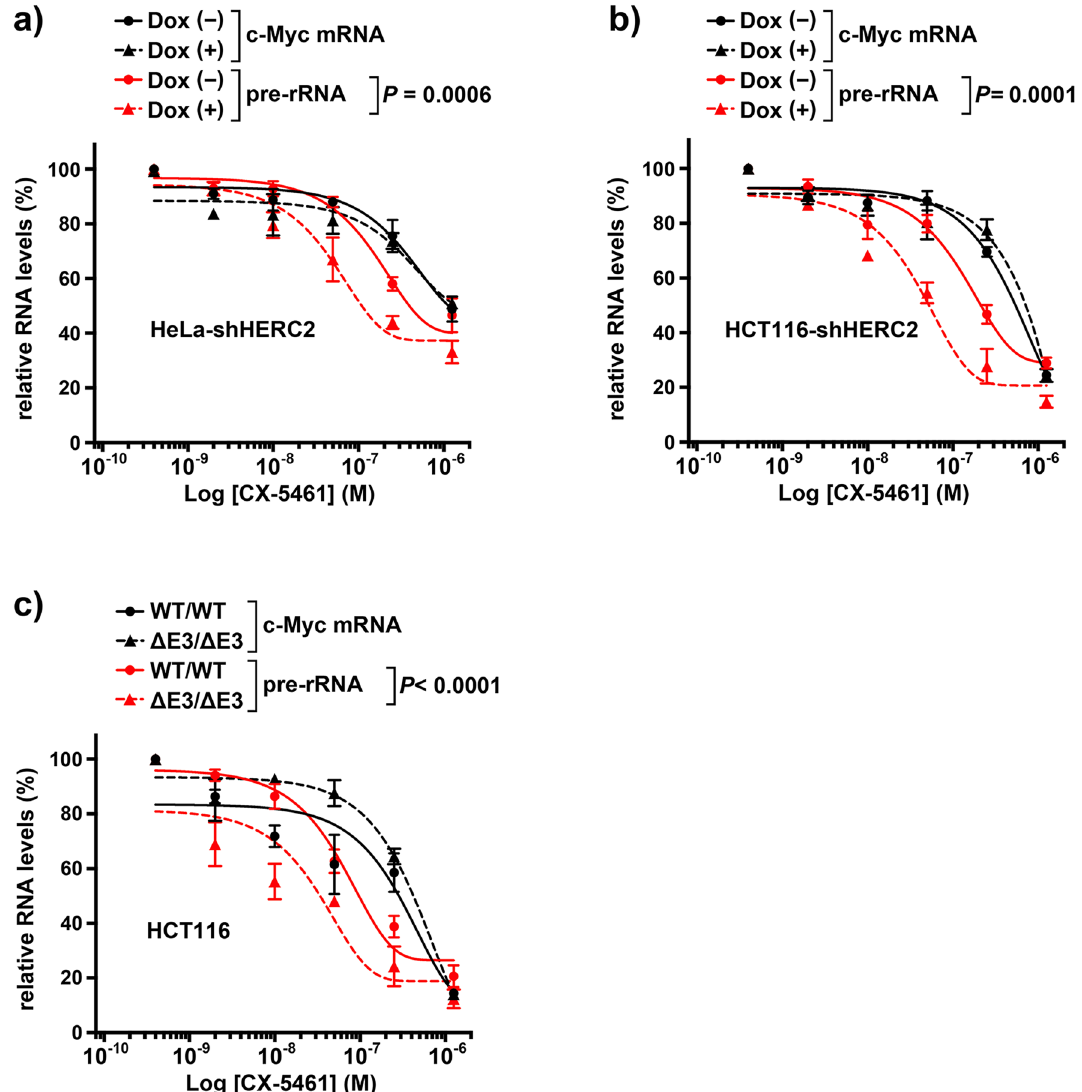
Figure 5. HERC2 dysfunction enhances the inhibitory effect of CX-5461 on pre-rRNA transcription. HeLa- shHERC2 (a) or HCT116-shHERC2 (b) cells untreated (solid line) or treated with Dox (dashed line), and wild-type (solid line) or HERC2 ΔE3/ΔE3 (dashed line) HCT116 cells (c) were incubated with the indicated dose of CX5461. Inhibition of pre-rRNA (red) and c-Myc mRNA (black) transcription was analyzed by qRT-PCR, and was normalized against β-actin mRNA expression levels (see Supplementary Figure S8 for the expression level of β-actin mRNA). Data are shown as the means ± S.D of three independent experiments. P -values of interactions were calculated using two-way ANOVA. The concentration that inhibited 50% of the RNA products (IC50 value) was as follows: (a) pre-rRNA Dox (−): 0.77 μmol/l, Dox ( +): 0.21 μmol/l, others: n.a., (b) c-Myc-mRNA Dox (−): 0.47 μmol/l, Dox ( +): 0.52 μmol/l, pre-rRNA Dox (−): 0.26 μmol/l, Dox ( +) 0.06 μmol/l, (c) c-Myc- mRNA WT/WT: 0.15 μmol/l, ΔE3/ΔE3: 0.35 μmol/l, pre-rRNA WT/WT: 0.13 μmol/l, ΔE3/ΔE3 0.03 with different doses of CX-5461. Expression levels of pre-rRNA and c-Myc mRNA were determined via qRT- PCR. The expression of pre-rRNA was more significantly suppressed than that of c-Myc mRNA (Fig. 5A) in concordance with the findings of a previous report 37 , which suggests relatively specific effect of this agent on the transcription by Pol I compared to that by Pol II. Importantly, depletion of HERC2 significantly reduced the expression of pre-rRNA, whereas it did not affect the expression of c-Myc mRNA (Fig. 5A). The same results were recapitulated in HCT116-shHERC2 cells (Fig. 5B) and HCT116-HERC2 ΔE3/ΔE3 cells (Fig. 5C). These results indi- cate that HERC2 dysfunction sensitizes cells to CX-5461-mediated suppression of rRNA synthesis. Interestingly, we observed that CX-5461 reduced the nucleolar localization of BLM and WRN (Supplementary Figure S9). This suggests that reduced rDNA transcription by HERC2 inactivation may be responsible for the observed alteration in BLM and WRN localization (Figs. 1 and 2). However, depletion of HERC2 or HERC2 ΔE3/ΔE3 on its own did not suppress the pre-rRNA expression in the absence of CX-5461 (Supplementary Figure S10). This indicates that HERC2 regulates localization of BLM and WRN independent of the suppression of rDNA transcription.